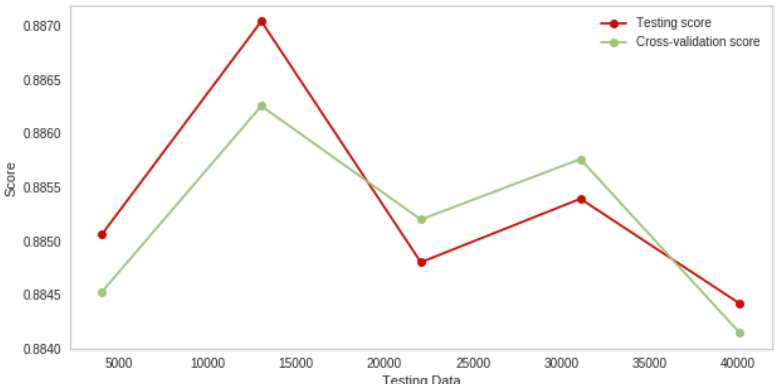
Figure 12. Logistic regression testing learning curve.